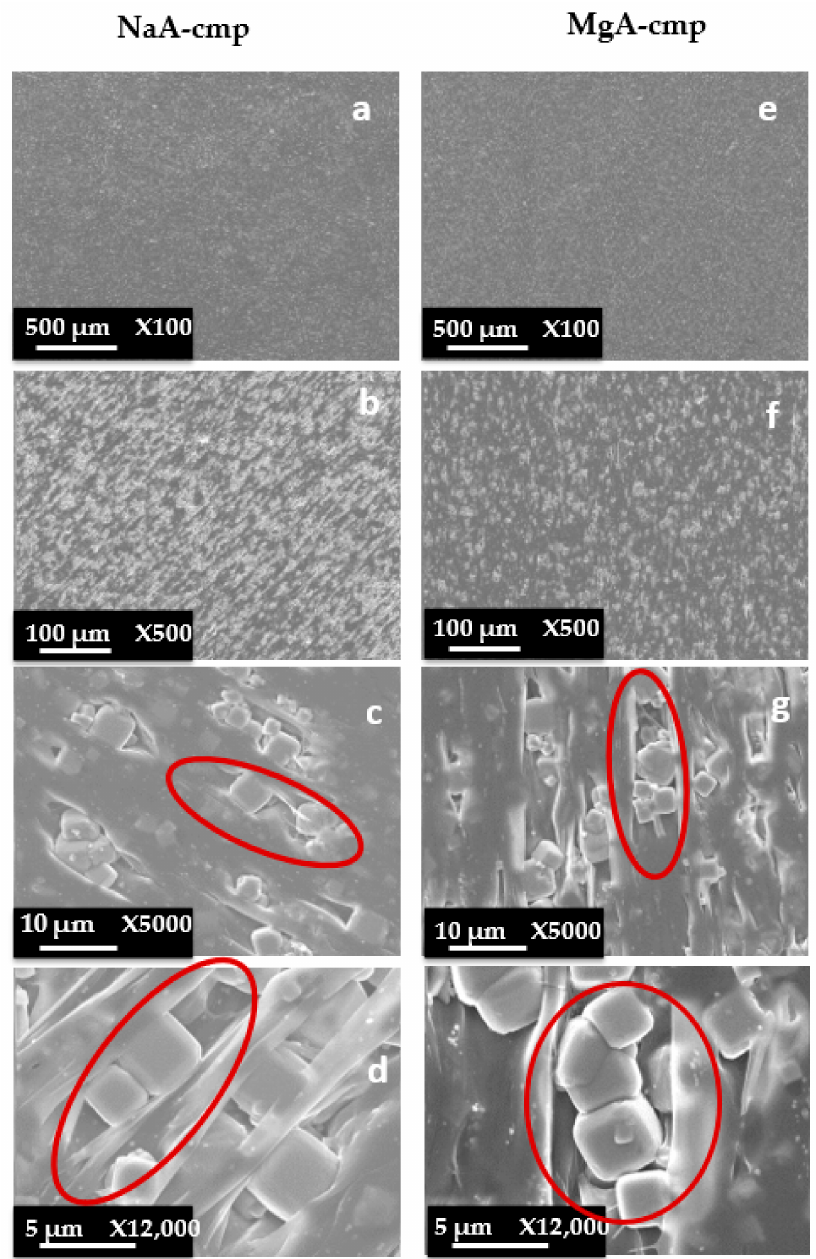
Figure A4. SEM images at different magnifications of molded part forms (top view) of ( a – d ) NaA-cmp and ( e – h ) MgA-cmp